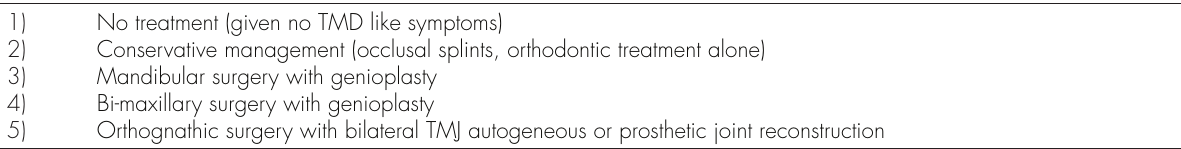
Table III. Treatment options for the